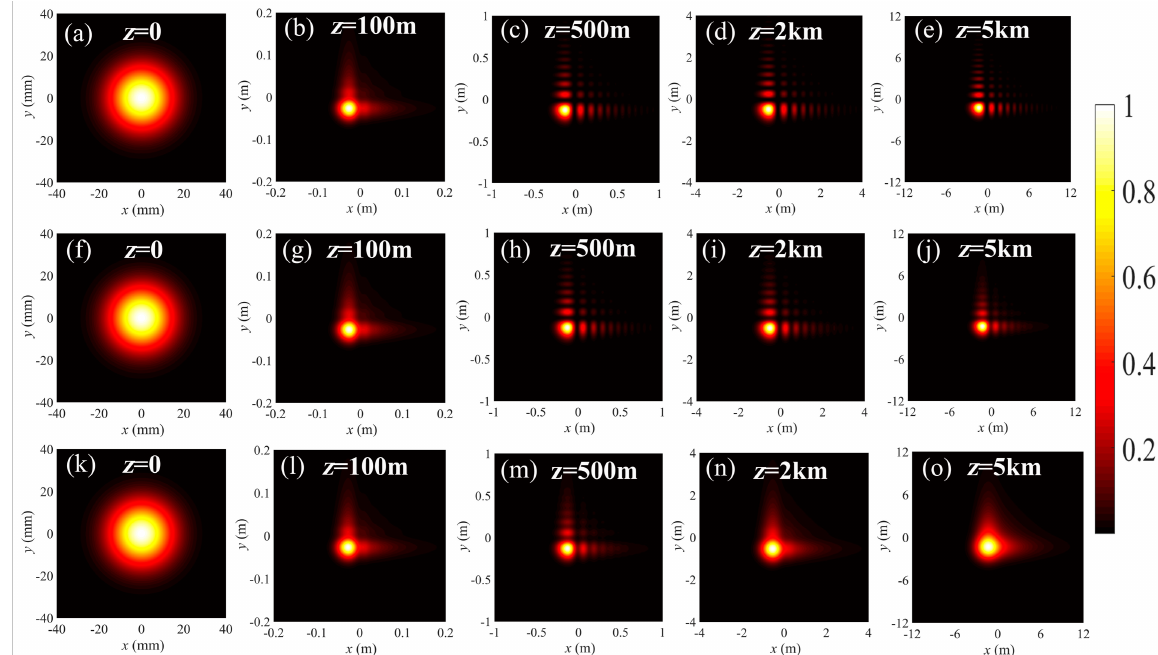
Figure 1. Normalized spectral density of modified complex Lorentz–Gaussian-correlated (MCLGC) beam propagation in marine turbulence at several propagation distances. ( a – e ) in free space ( C n 2 = 0); ( f – j ) in turbulence with C n2 = 5 × 10 –14 m –2/3 ; ( k – o ) in turbulence with C n 2 = 5 × 10 –13 m –2/3